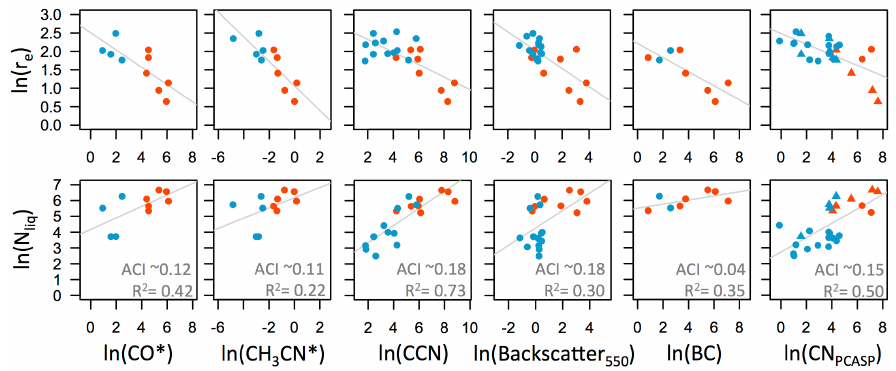
Figure 7. Same as in Fig. 5, but for data from the multi-campaign analysis. As in Fig. 5, CO* indicates that background values of 99.2ppbv have been subtracted. For CH 3 CN, the * indicates background values of 0.018ppbv have been subtracted (due to low background CH 3 CN levels in some of the samples).